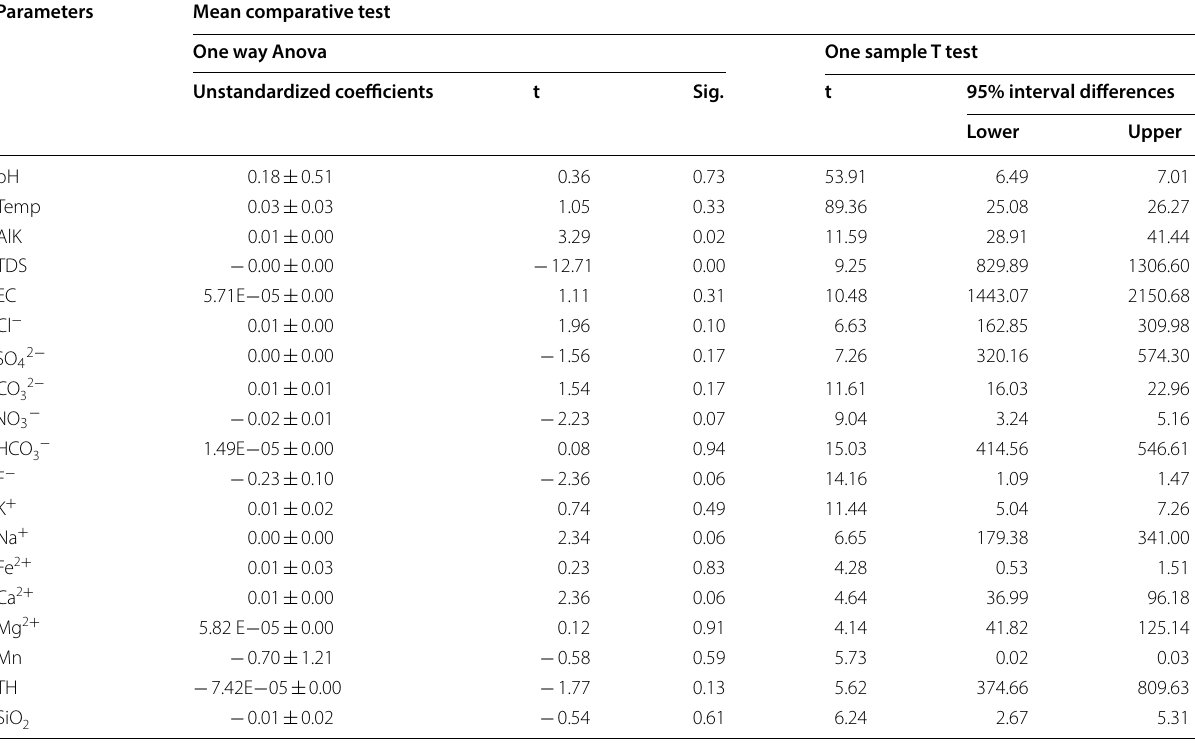
Table 8 Mean comparative analysis obtained from the water quality parameters